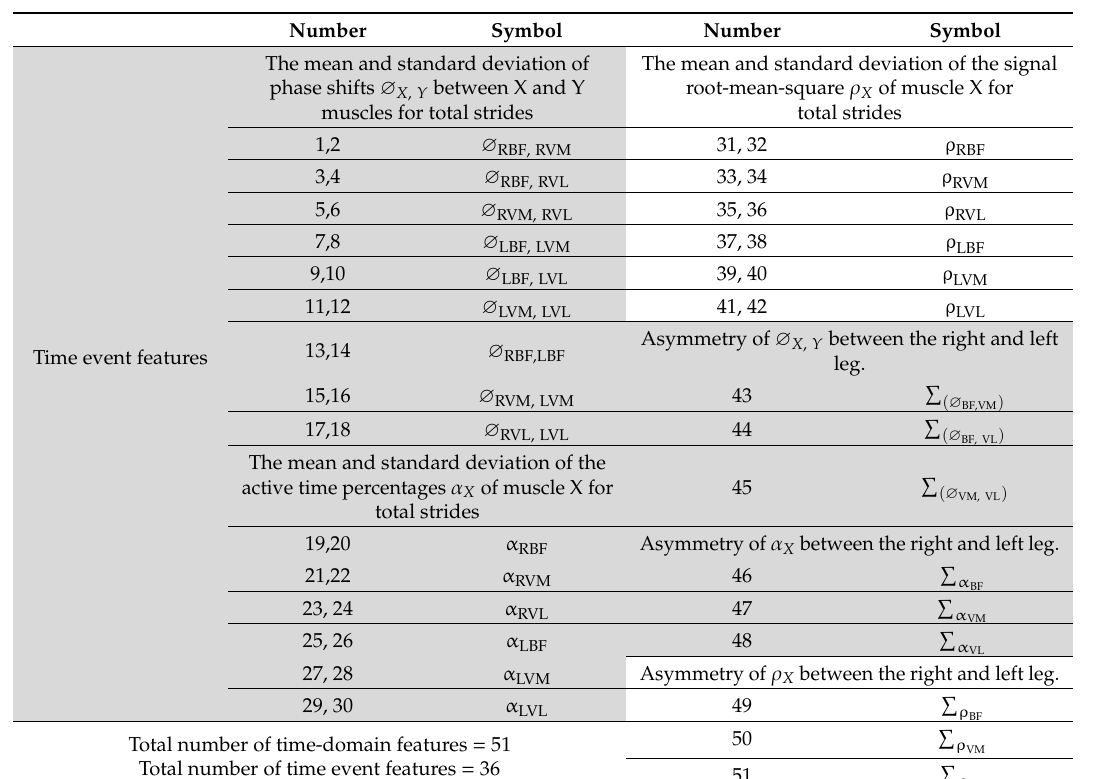
Table 2. Time domain and time event features (shaded grey) of sEMG signals. Two numbers assigned to a feature correspond to the arithmetic mean and standard deviation of that